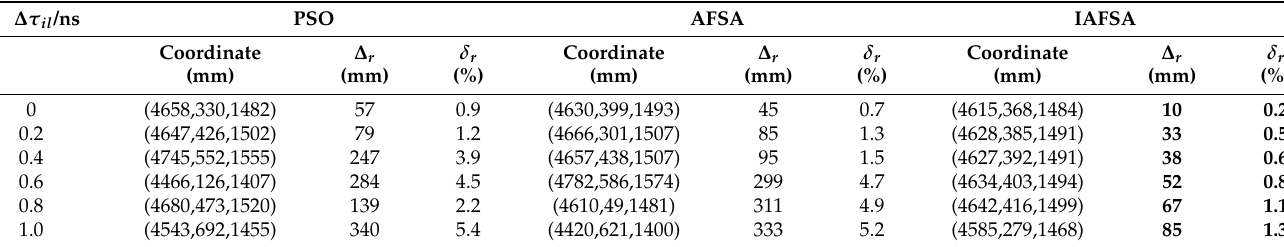
Table 6. Location results with the different delay